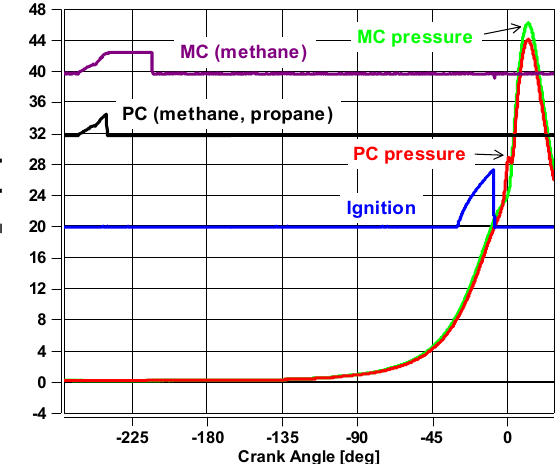
Figure 3. An example of the waveform of the recorded signals with the description of the fuels fed to both combustion chambers (start of fuel feeding to both chambers at the angle α = 260 deg bTDC).